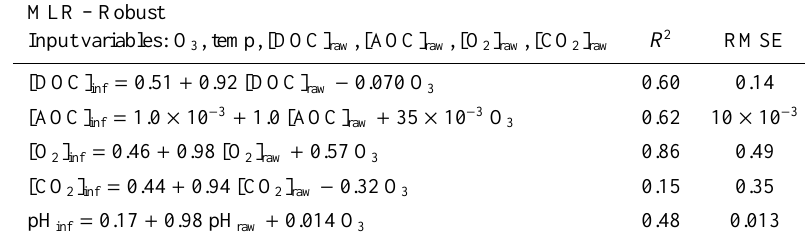
Table 2. MLRs water quality parameters after ozonation. MLR – Robust